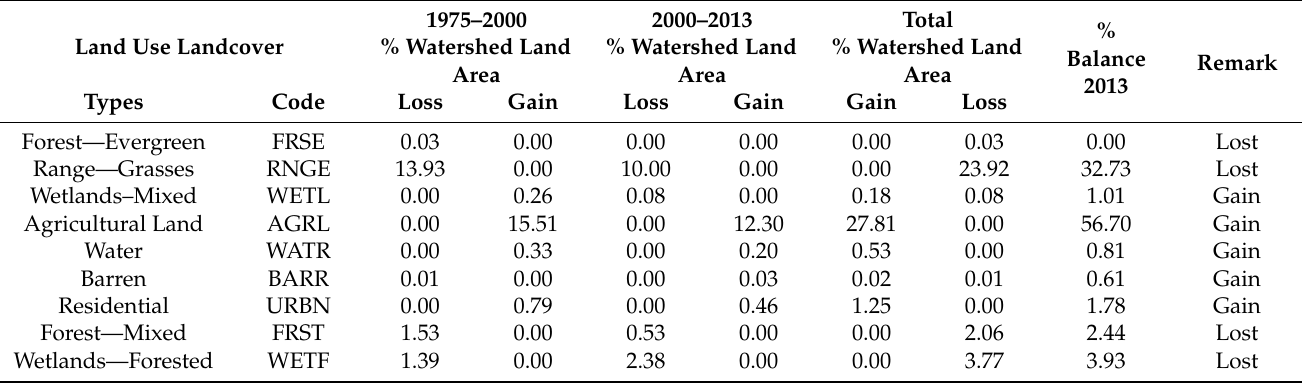
Table 5. Percentage changes in the land-use area in the watershed between 1975 and 2013. Note the significant losses of evergreen forests, range grasses, forest mixed and wetland forest, and the converse gain in other land-use